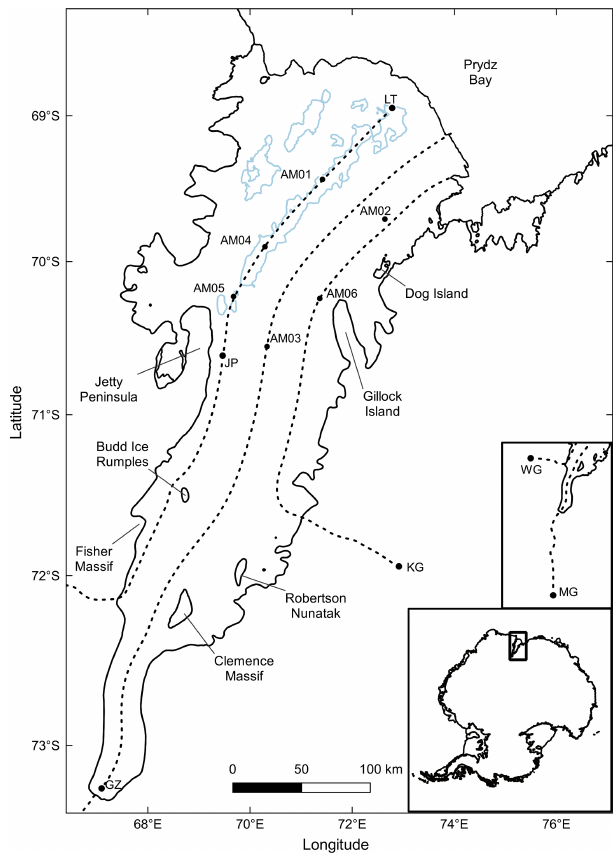
Figure 1. The Amery Ice Shelf with significant features and AM01– AM06 borehole locations. Three dashed lines, derived from MEa- SUREs InSAR-based Antarctic ice velocity data (Rignot et al., 2017), indicate the particular ice flowlines used in this study. The Jetty Peninsula flowline (hereafter JP flowline) starts from what we term the West Tributary Glacier (WG), passes through Jetty Peninsula point (JP), AM05, AM04 and AM01 boreholes, and ends at the “Loose Tooth” point (LT). The terminology of the flowline points JP and LT follows Craven et al. (2009), but the specific loca- tions are slightly different. The AM03 flowline originates from Mel- lor Glacier (MG), passes through Grounding Zone point (GZ) and AM03 borehole, ending at the ice front. The AM06 flowline orig- inates from Kronshtadtskiy Glacier (KG), passes through AM06 borehole and passes close to AM02 borehole. Marine ice regions with thickness greater than 100m are shown with the light blue con- tours (Fricker et al., 2001). The locations of the grounding mask and the ice front are from Depoorter et al. (2013). Insets show the ori- gins of the JP and AM03 flowlines and location of the AIS in East